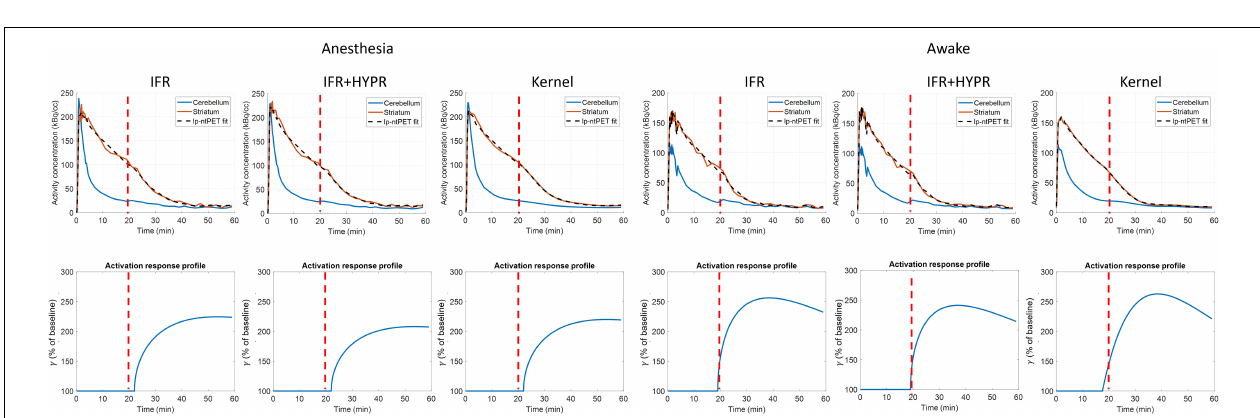
FIGURE 5 | Rest and active parametric γ mean (top row) and standard deviation (bottom row) images, for independent frame reconstruction (IFR), independent frame reconstruction with HYPR denoising (IFR+HYPR), and spatiotemporal kernel reconstructions (Kernel).